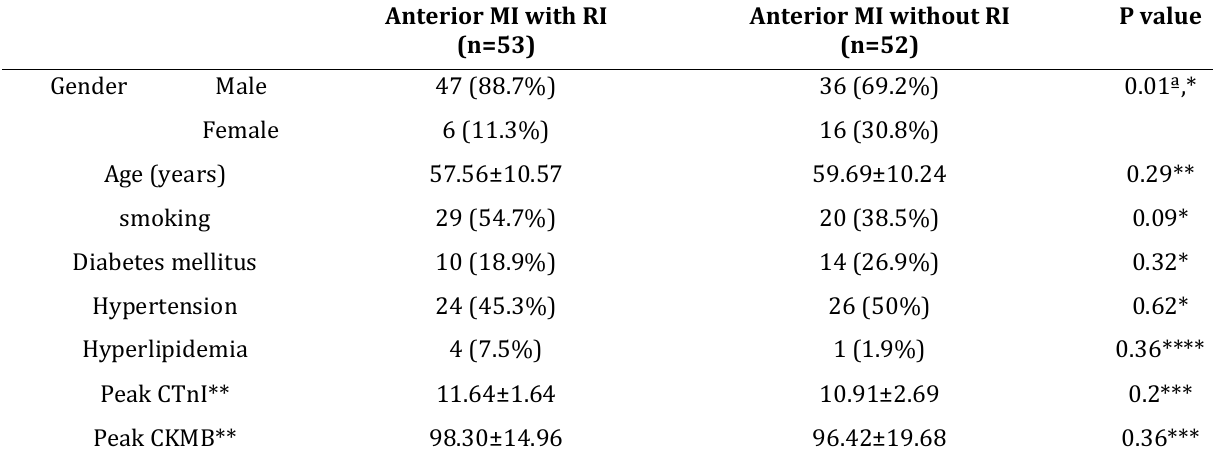
Table 1: Baseline and laboratory 8indings between two groups